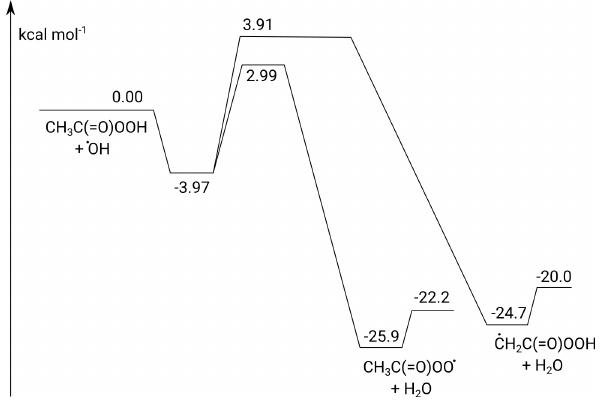
Figure 8. ZPE-corrected potential energy surface of the CH 3 C(O)OOH + OH reaction calculated at the CCSD(T)/CBS(DTQ)//M06-2X-D3/aug-cc-pVQZ level of theory.